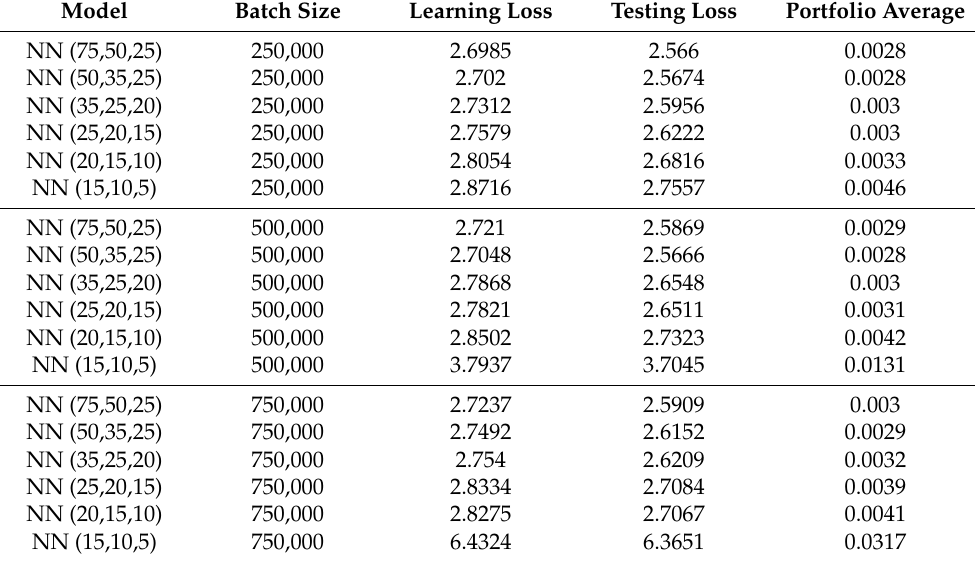
Table A8. The testing loss, learning loss, and portfolio average of the Poisson neural network models with different architectures for 250,000 and 500,000 and 750,000 batch